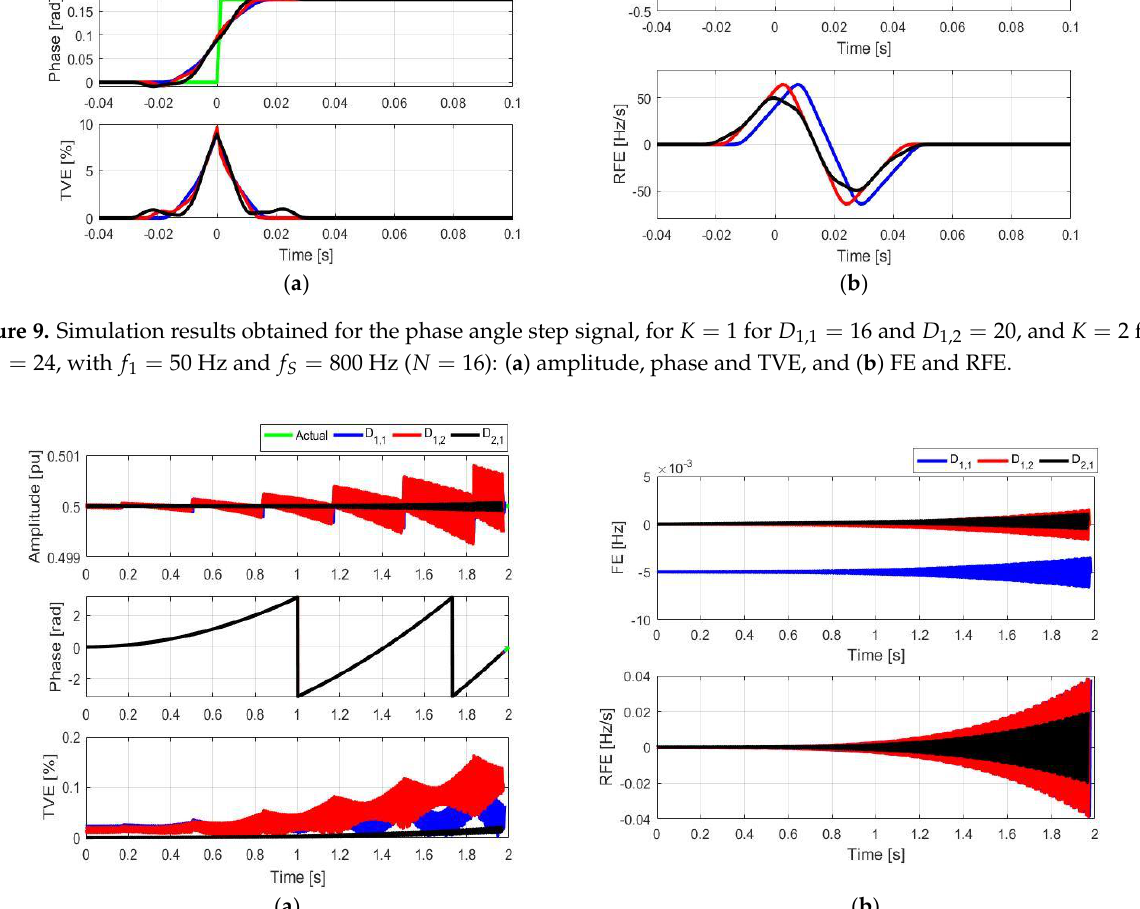
Figure 10. Simulation results obtained for the frequency ramp of 1 Hz/s, for 𝐾 = 1 for 𝐷 1,1 = 16 and 𝐷 1,2 = 20 , and 𝐾 = 2 for 𝐷 2,1 = 24, with 𝑓 1 = 50 Hz and 𝑓 𝑆 = 800 Hz ( 𝑁 = 16 ): ( a ) amplitude, phase and TVE, and ( b ) FE and RFE.